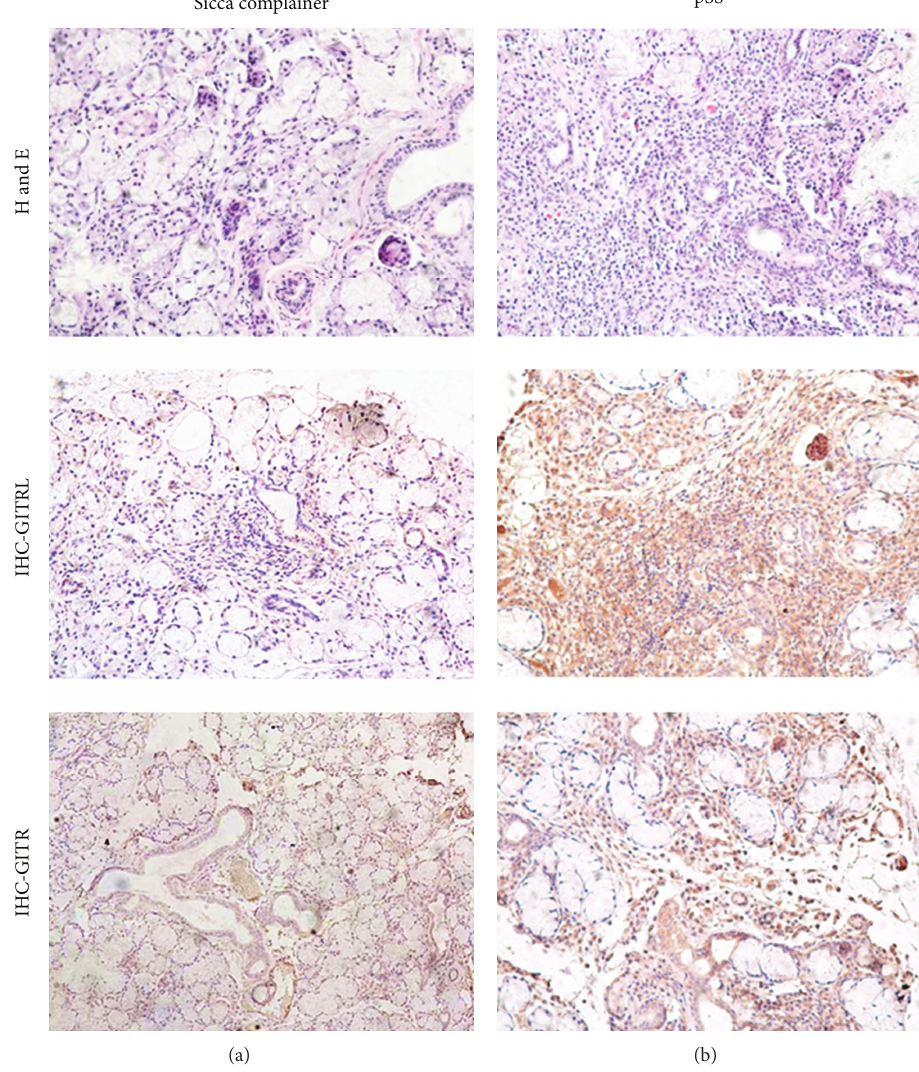
Figure 5: High expression of GITRL and GITR in labial salivary glands from patients with pSS. The labial salivary glands (LSG) of pSS patients exhibit increased GITRL and GITR expression. Shown is the expression of the GITRL and GITR in the labial salivary glands of sicca complainer ( 𝑛 = 6 , left column) and patients with pSS ( 𝑛 = 10 ; right column), as determined by immunostaining using specific antibodies. The cells that stained with the antibodies appeared in brown. The infiltrating lymphocytes and periductal areas of LSG from the patients with pSS exhibited intense GITRL and GITR staining, whereas the expression of GITRL was stronger and more widely distributed than GITR. In contrast, the sicca complainers did not exhibit any GITRL or GITR expression in their labial salivary